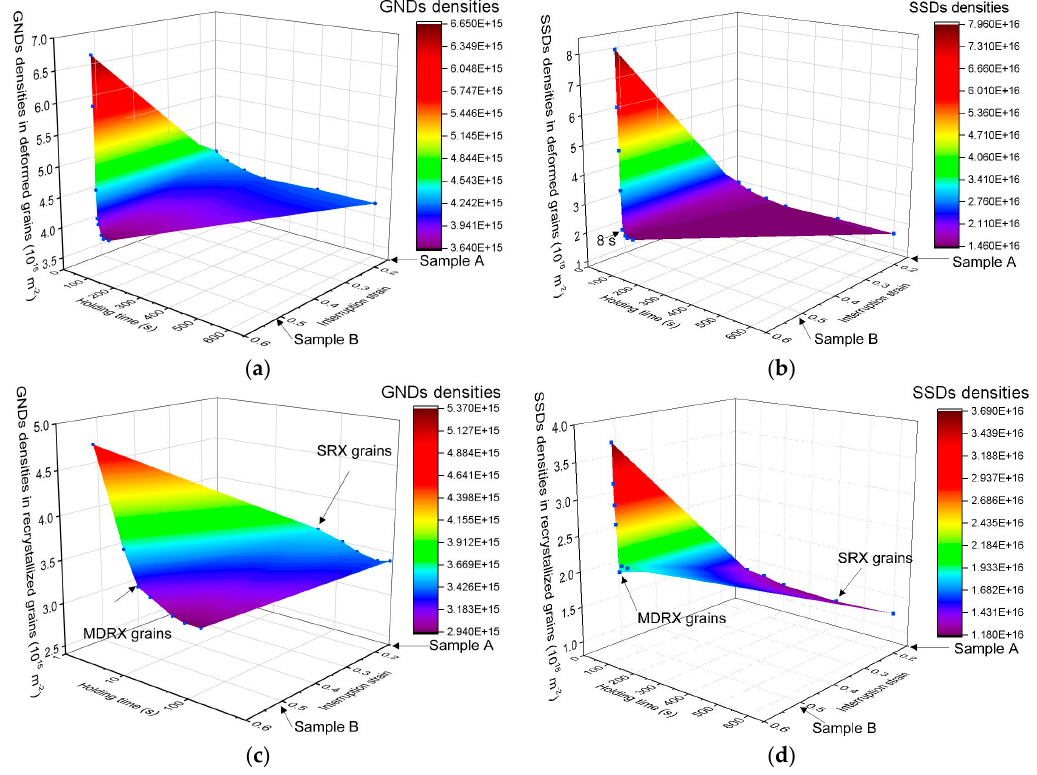
Figure 13. The variation of dislocation density with the holding times: ( a ) GNDs densities of deformed grains in sample A and B; ( b ) SSDs densities of deformed grains in samples A and B; ( c ) GNDs densities of MDRX grains and SRX grains in samples A and B; ( d ) SSDs densities of MDRX grains and SRX grains in samples A and B.